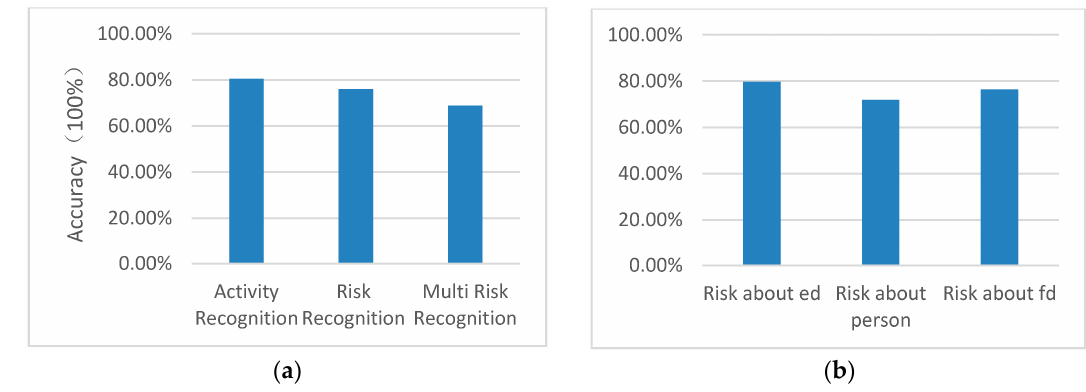
Figure 25. Accuracy rate of the experimental results. The first one ( a ) shows the accuracies of activity recognition, risk recognition and multi risk recognition. The second one ( b ) shows the accuracies of different types of risk (about ed, person and fd)